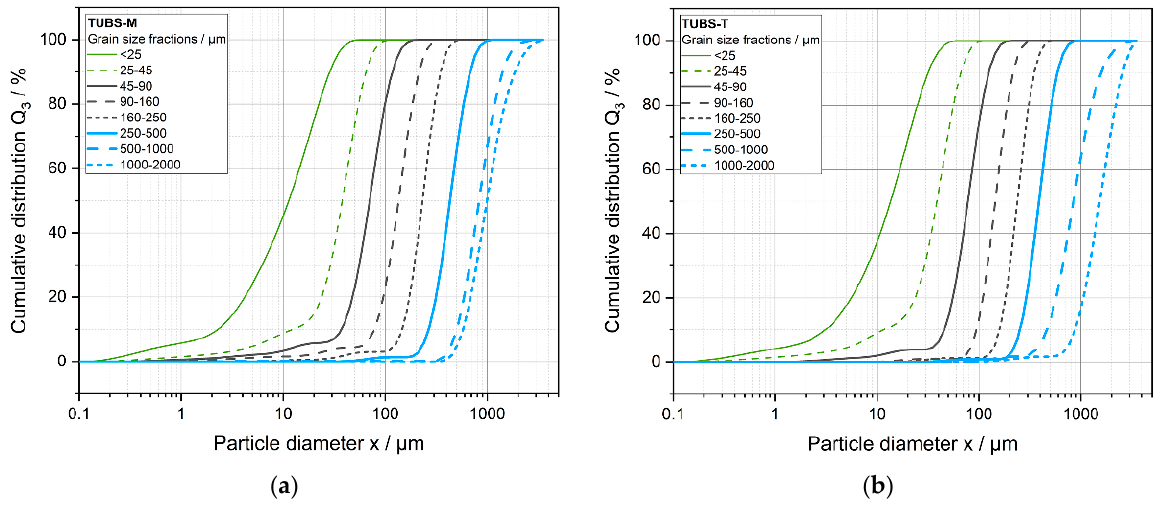
Figure 5. Cumulative particle size distributions of the grain size fractions of TUBS-M ( a ) and TUBS-T ( b ) measured by LS. Particle diameter equals particle size. Table 1. Particle sizes of the grain size fractions of both regolith simulants.